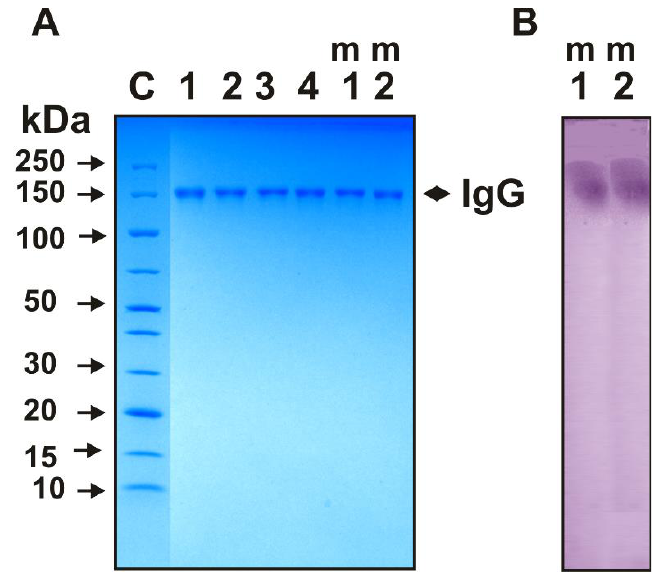
Figure 1. SDS-PAGE analysis of 14 µg IgGs electrophoretic homogeneity of four individual Abs (lanes 1–4) and equimolar mixtures of 30 preparations corresponding IgGs from Th (lane m1; Th-IgG mix ) and 2D2 (lane m2; 2D2-IgG mix ) mice using nonreducing 4–15% gradient gel ( A ). Lane C corresponds to a mixture of proteins with known molecular weights ( A ). In situ peroxidase activity analysis of m1 and m2 IgG mix ( B ). After SDS-PAGE, two longitudinal strips of gel were incubated using special conditions for protein refolding. Then, the peroxidase activity was revealed by incubating gel slices for 10 h in the standard reaction mixture containing DAB and H 2 O 2 until a coloured insoluble oxidation product was formed.